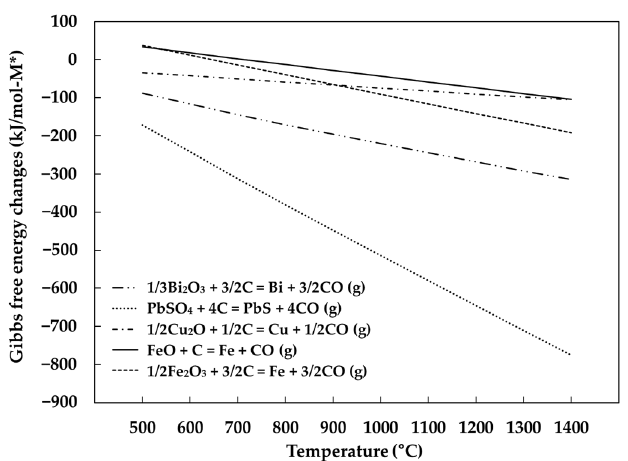
Figure 10. The Gibbs free energy changes for carbothermic reduction of some metal oxides and sulfates. (* M : Element of Metal)